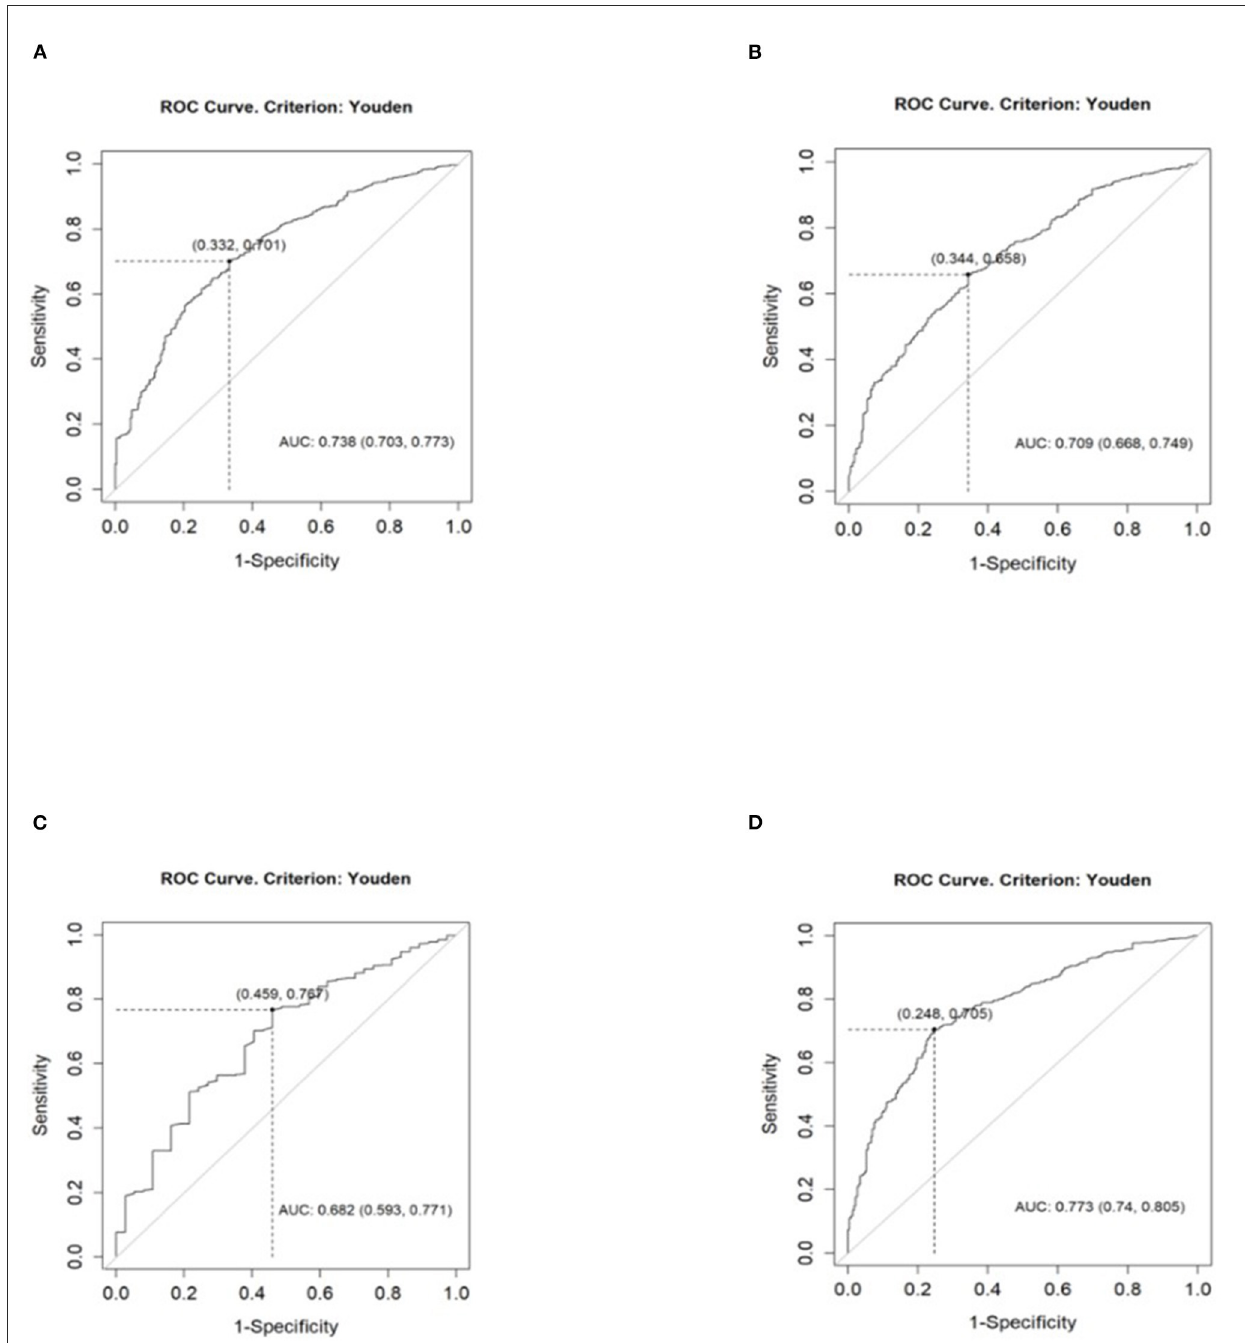
FIGURE1 Analysis of cutoff point of anthropometric indices for higher risk of hypertension in 9-year follow-up with the use of the ROC curve. (A) BMI cutoff point: 26.11 kg/m2. (B) WHR in women cutoff point: 0.83. (C) WHR in men cutoff point: 0.91. (D) Waist-to-height ratio cutoff point: 0.53.